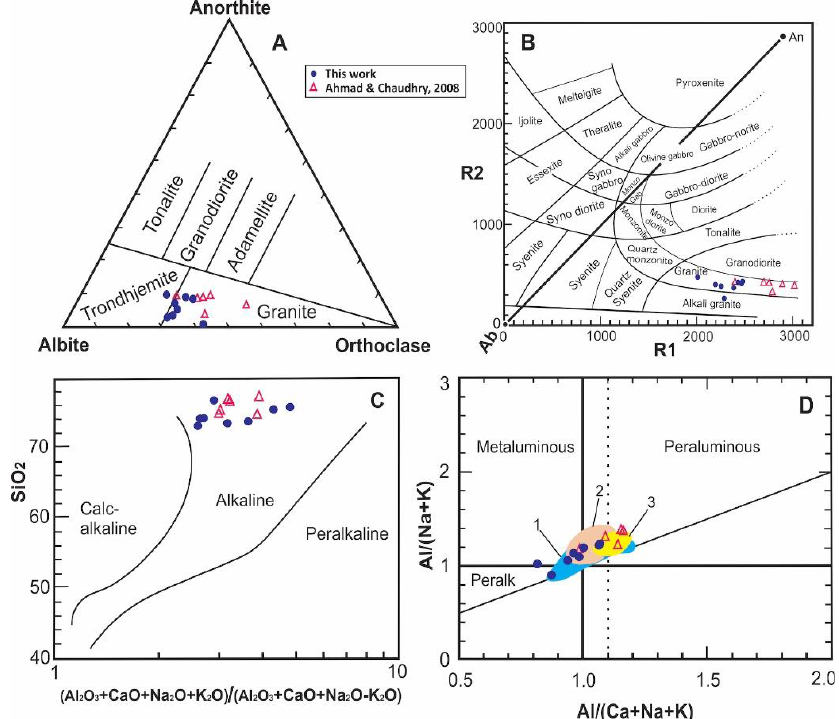
Figure 4. Classification of Wadhrai granite according to different chemical schemes. ( A ) Normative anorthite – albite – orthoclase classification [18]. ( B ) R1 (4Si − 11(Na + K) − 2(Fe + Ti)) vs. R2 (6Ca + 2(Mg + Al)) classification scheme of De La Roche et al. [19]. ( C ) SiO 2 vs. (Al 2 O 3 + CaO + Na 2 O + K 2 O)/(Al 2 O 3 + CaO + Na 2 O − K 2 O) relations classification diagram after [20]. ( D ) Molecular Al/(Na + K) vs. Al/(Ca + Na + K) diagram after [21]. Dashed line separates granites of igneous source (left) from granites derived from sediments (right). Fields for A-type granites are for comparison: 1 — Junggar (Siluro-Devonian) granite, Central Asian orogenic belt, NW China [22], 2 — Hasanrobat Per- mian granite, Sanandaj-Sirjan belt, Iran [23], 3 — KhalifanVariscan granite, NW Iran [24].